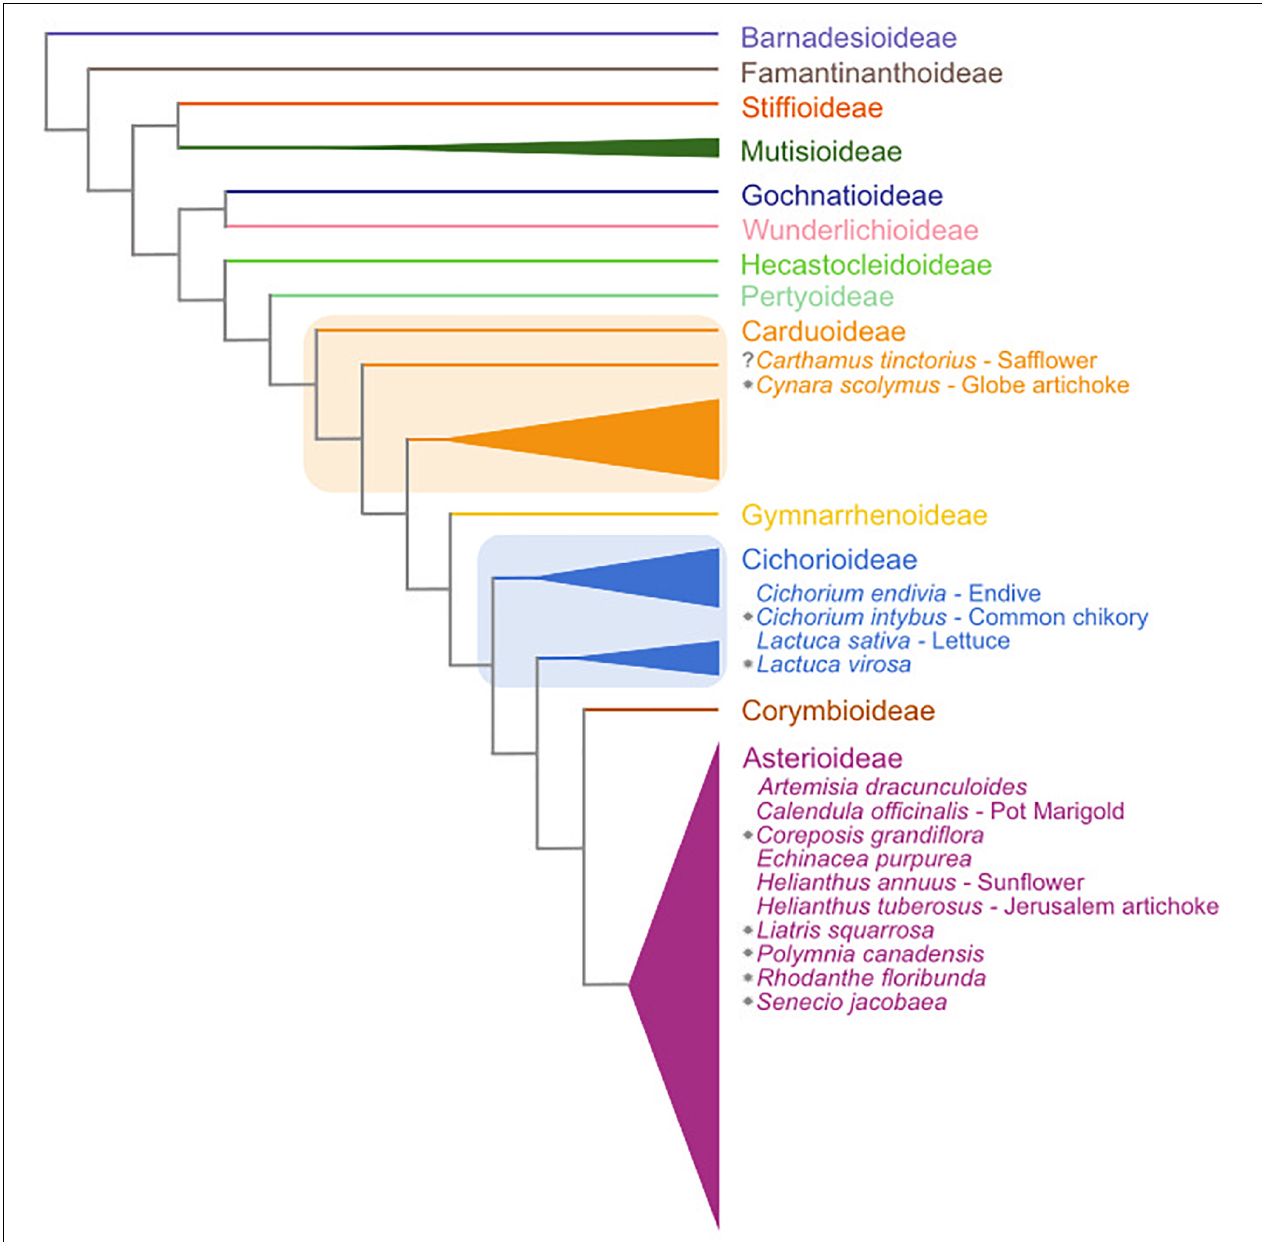
FIGURE 1 | Schematic overview of the subfamilies of the Asteraceae family based on Mandel et al. (2019). Central Asteraceae crop species are listed in their respective subfamilies. Gray stars indicate species that have a documented vernalization response in flowering. Subfamily assignments are based on Fu et al. (2016) and Mandel et al. (2019). Note that two of the subfamilies (Carduoideae and Cichorioideae) are paraphyletic and are thus marked with